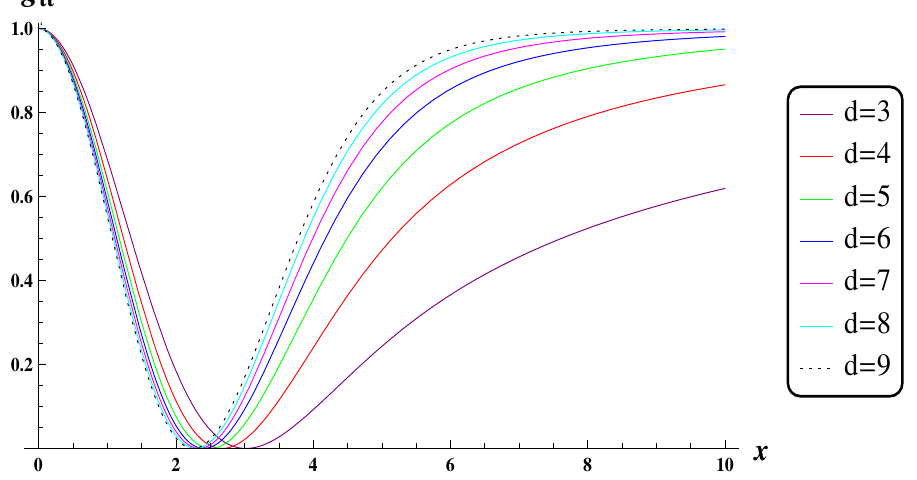
Figure 8. Time component of the extremal Schwarzschild metric in different dimensions vs. x = r √